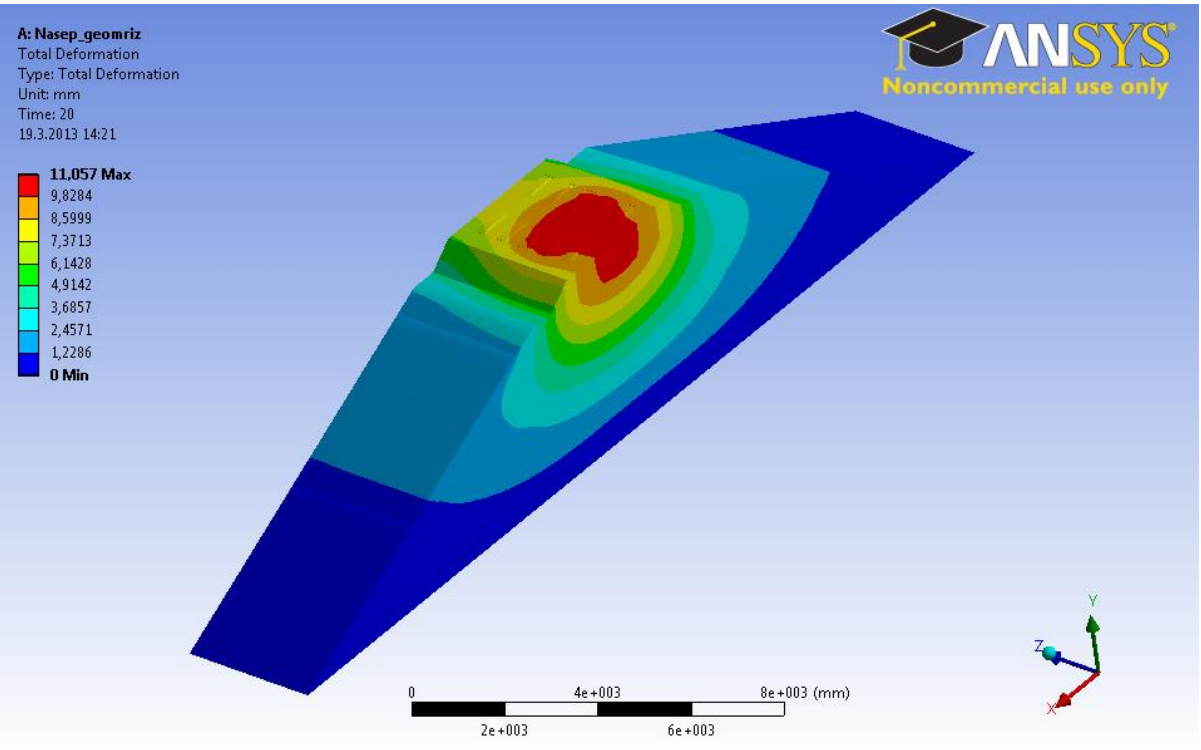
Figure 10. Total deformation of the embankment reinforced by the